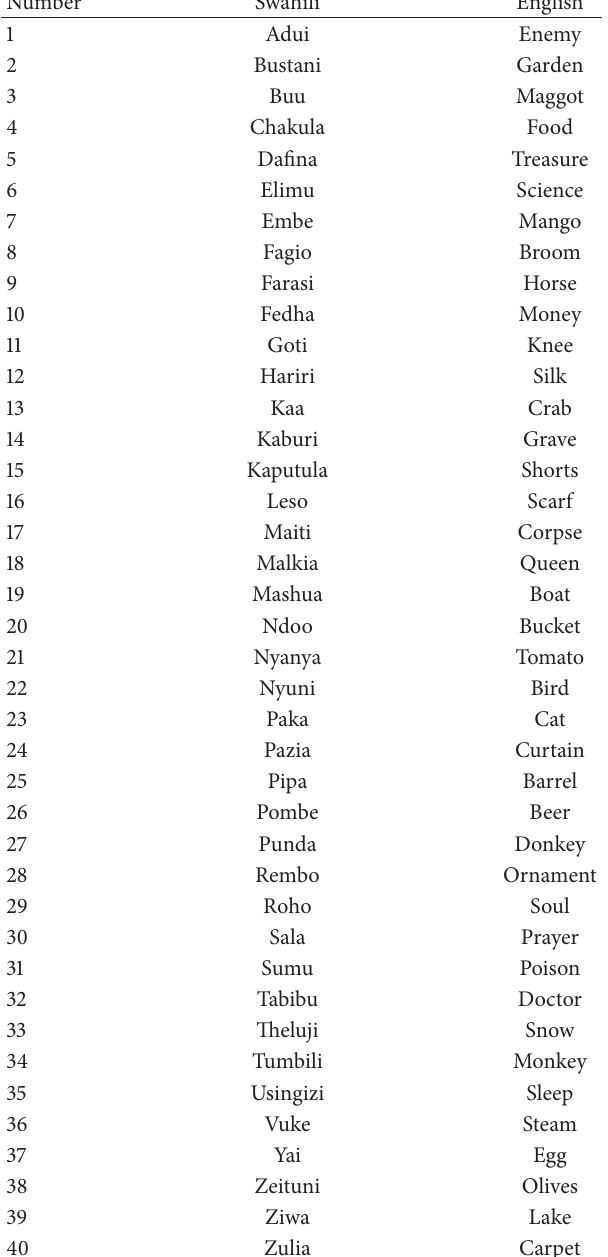
Table 1: The Swahili-English word pairs used in the experiment.